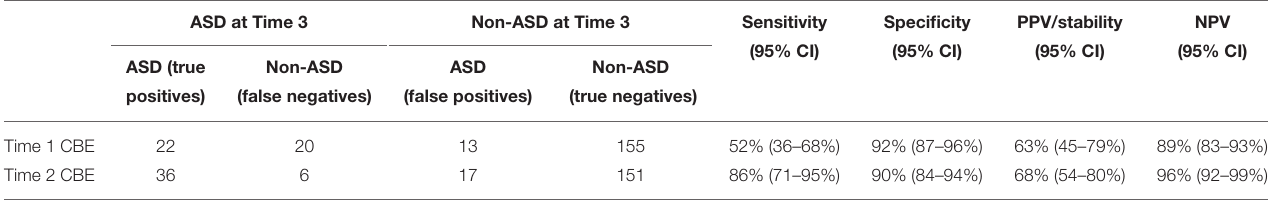
TABLE 3 | Stability and diagnostic classification parameters at Time 1 and Time 2. ASD at Time 3